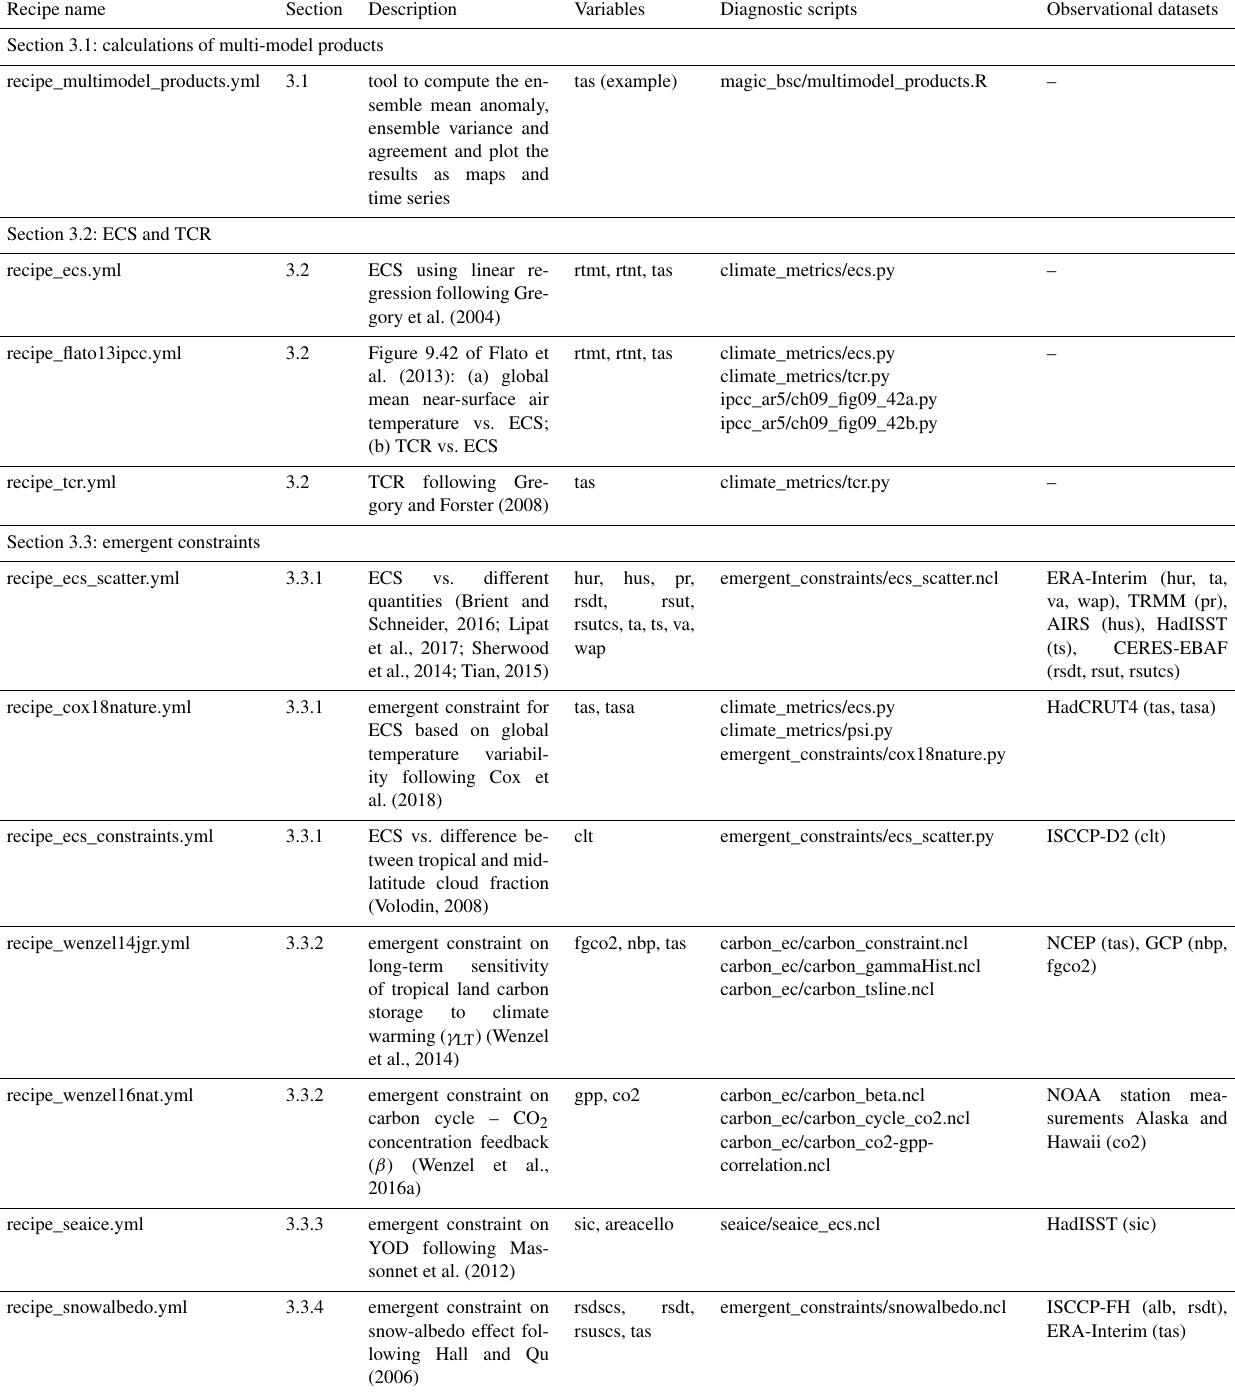
Table 1. Overview of recipes for emergent constraints and future projections implemented in ESMValTool (v2.0) along with the section where they are described, a brief description, the required CMIP5 variables, the diagnostic scripts included and the observational datasets used in the examples. All diagnostics expect time series of monthly mean data as input. For further technical details, we refer to the GitHub repository.